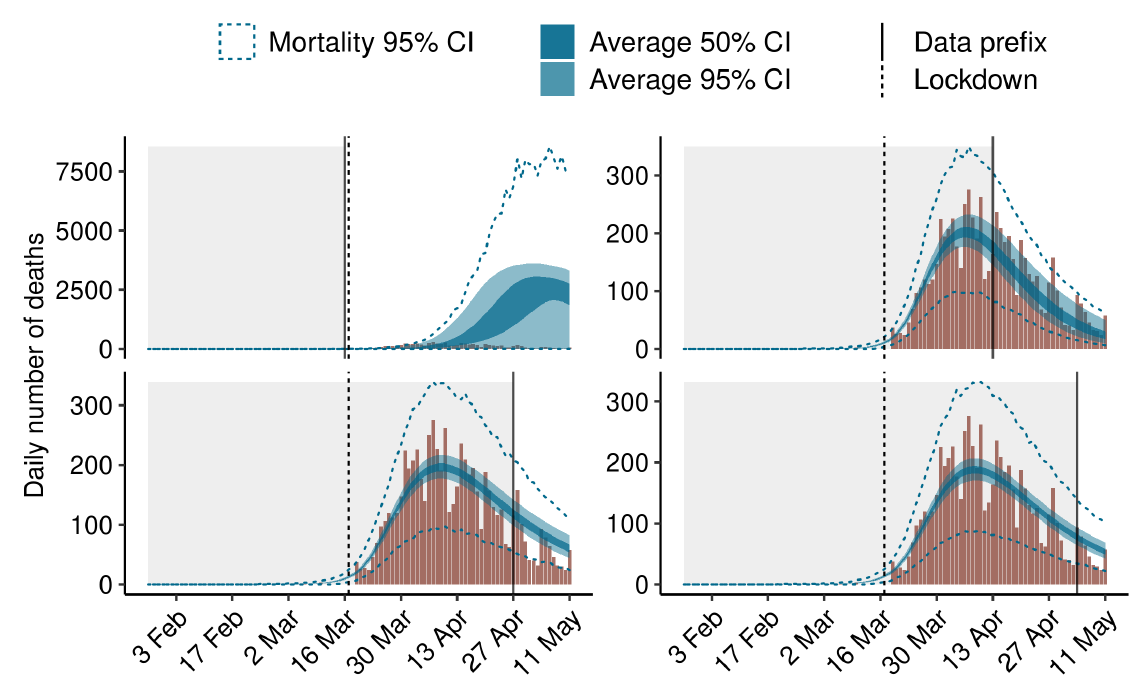
Figure 2 – Model fits using prefixes of data for region Île-de-France. The dashed vertical line corresponds to March 17, when the lockdown was enforced. Data right of the plain vertical line were hidden from the model. The observed numbers of deaths are repre- sented with a brown histogram, and the predictions of the model are in blue. Dark blue ribbons correspond to the 50% credibility intervals and light blue ribbons to the 95% credibility intervals of the expected numbers of death. Blue dashed lines represent the 95% credibility interval of the predicted numbers of deaths D t , m (see section